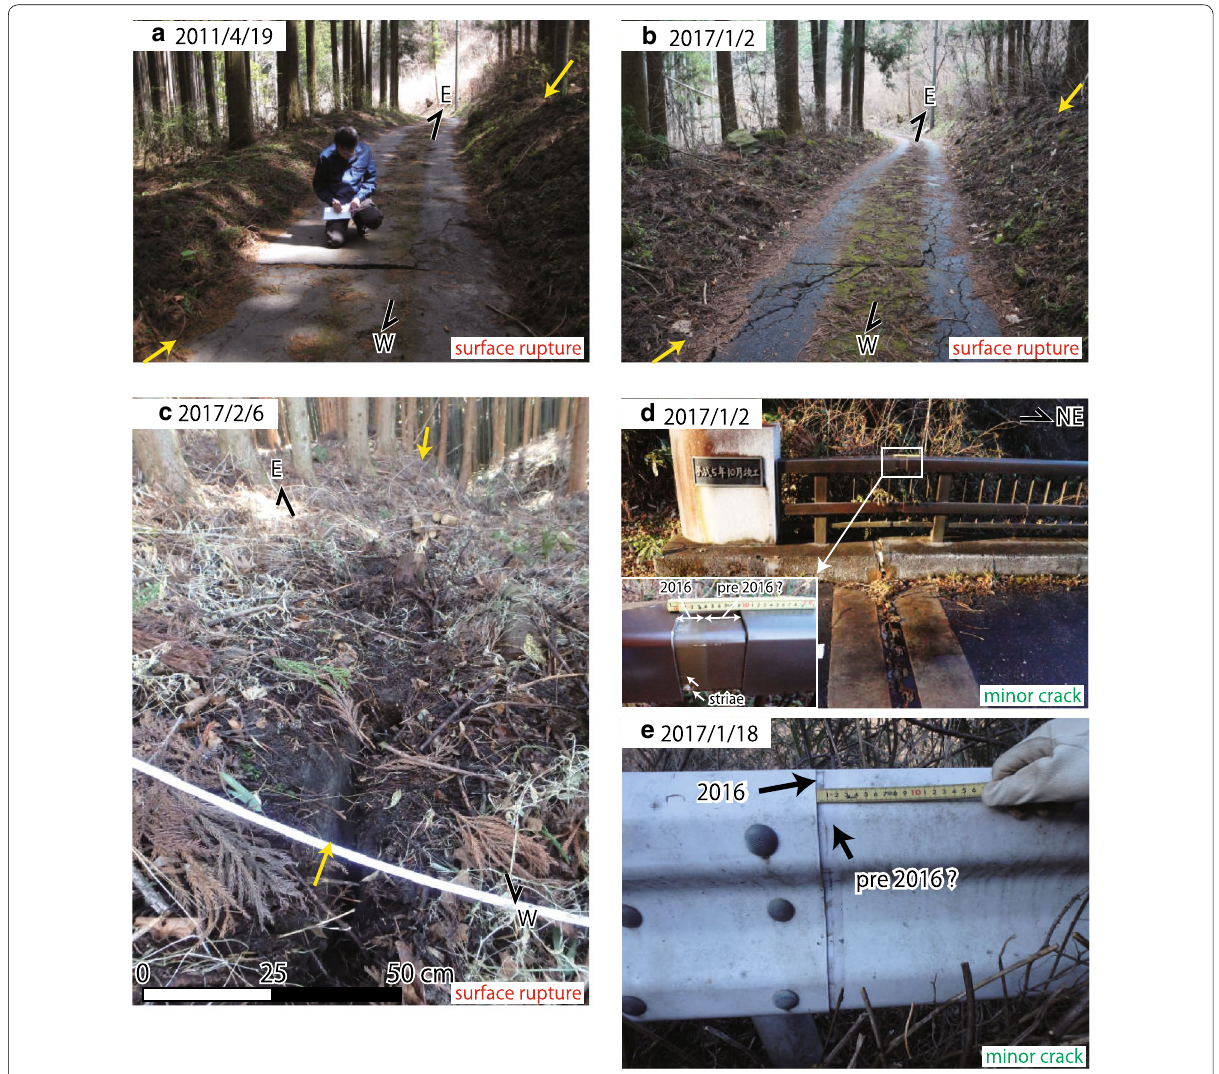
Fig. 5 Photographs of surface ruptures; locations in Fig. 2a, b. Yellow arrows show the inferred fault trace based on the ruptures and linear surface displacement of InSAR analysis. a Damage in an asphalt road near Mochiyama 1 month after the 2011 event. b Further damage at the same location 5 days after the 2016 event. The total extension was measured as 12–13 cm, but this may include extension from the 2011 event. c Open crack after the 2016 event near Mochiyama in the area of peak LOS displacement, showing slight southwest-down displacement. d Extension across the Shin-Koyama bridge after the 2016 event. Although we had not checked the Shin-Koyama bridge in the 2011 survey, the pattern of weathering in the exposed steel implies extension in a pre-2016 event, presumably the 2011 event. The fresh and weathered zones measured 4 cm and 5 cm, respectively. e Evidence of extension in a guardrail at the Shin-Koyama bridge after the 2016 event. Fresh and weathered zones measured 0.8 cm and 1.6 cm,